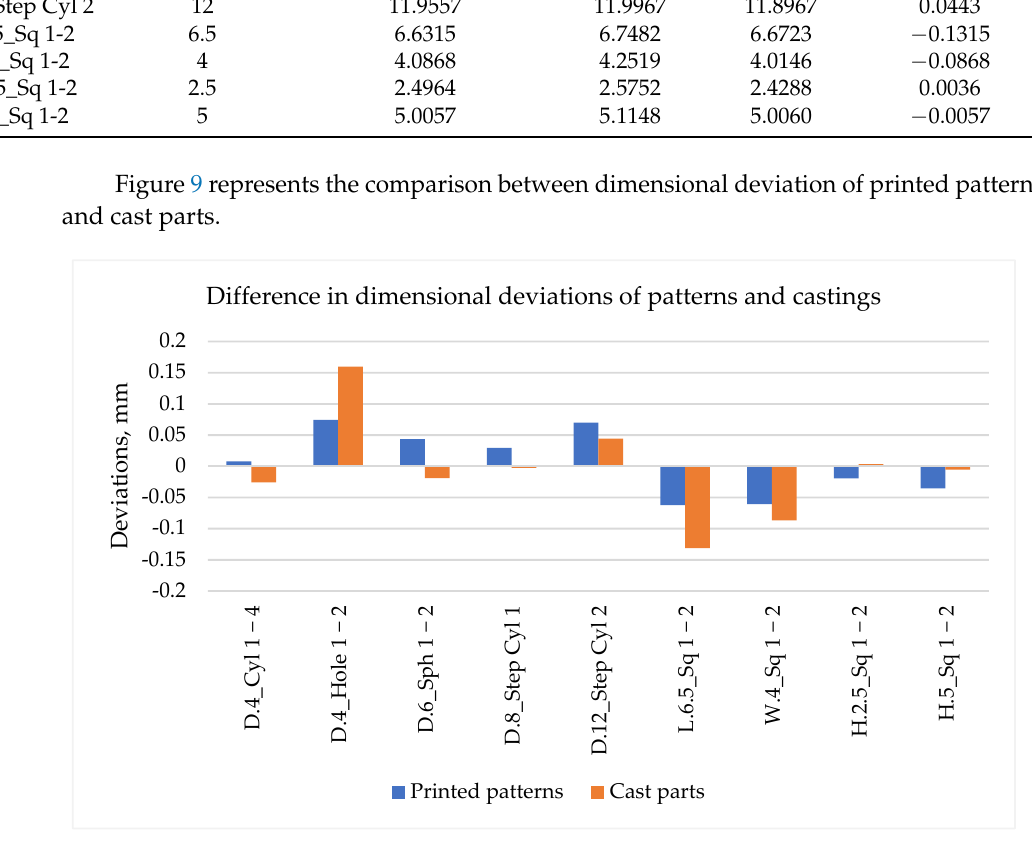
Figure 9. Comparison of dimensional deviations from the nominal value for patterns and castings. Comparing the dimensional deviation from nominal value between patterns and cast parts shown in Figure 9, the largest difference was observed in hole dimension with 0.0852 mm, and dimensional deviations of other features fluctuate between 0.229 mm and 0.0692 mm. It can be observed from Tables 9 and 16 and Figure 9 that the features which had positive deviations in printed patterns, had smaller positive or even